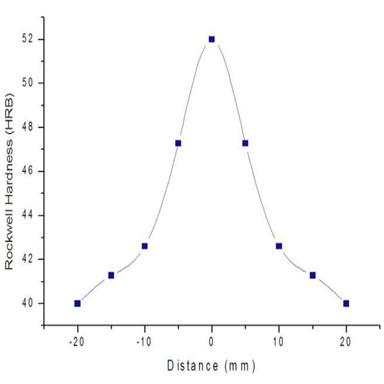
Microhardness of FS welded MMC.